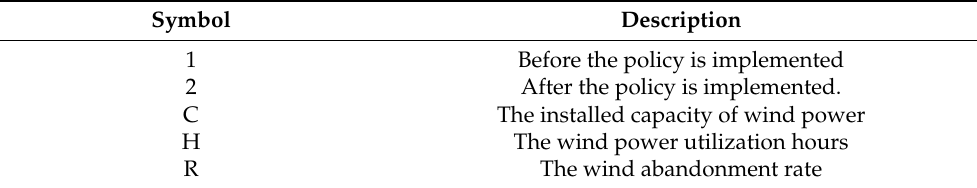
Table 8. Symbols and